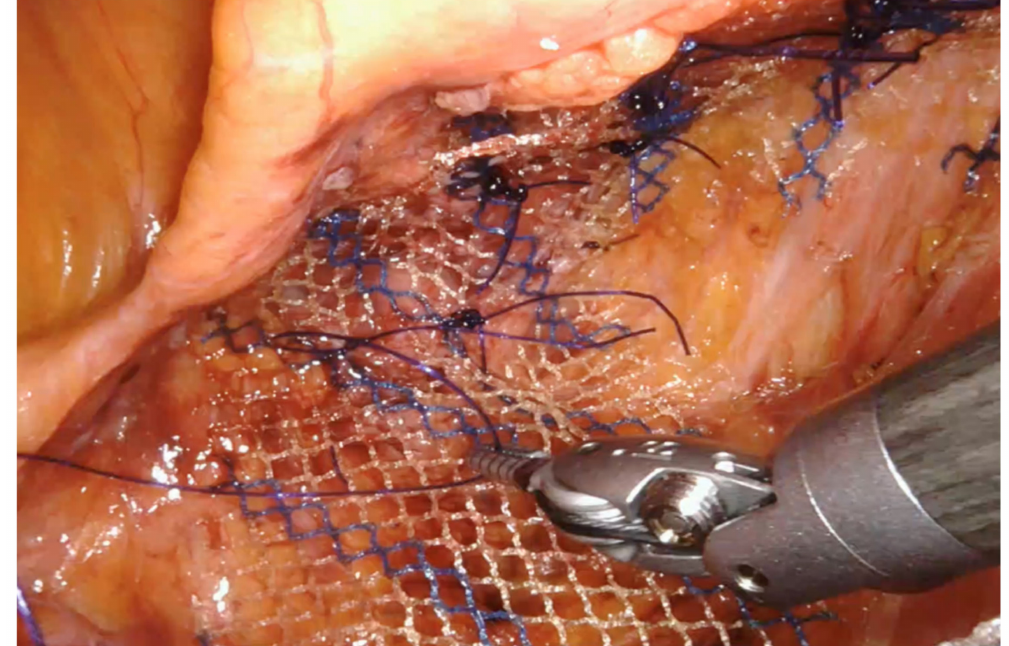
Figure 3. The mesh (macroporous polipropilene) is secured distally at the level of the anterior rectal wall with perma- nent